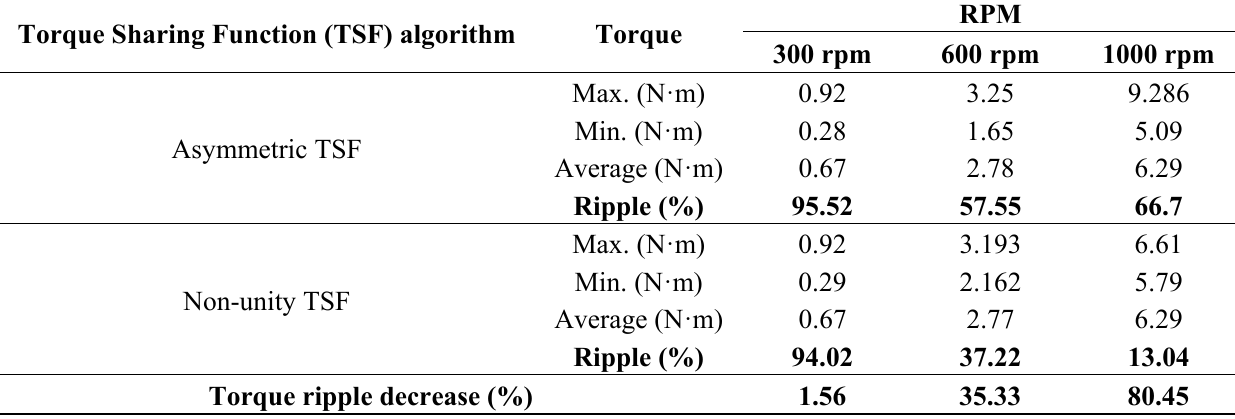
Table 1. Torque results.